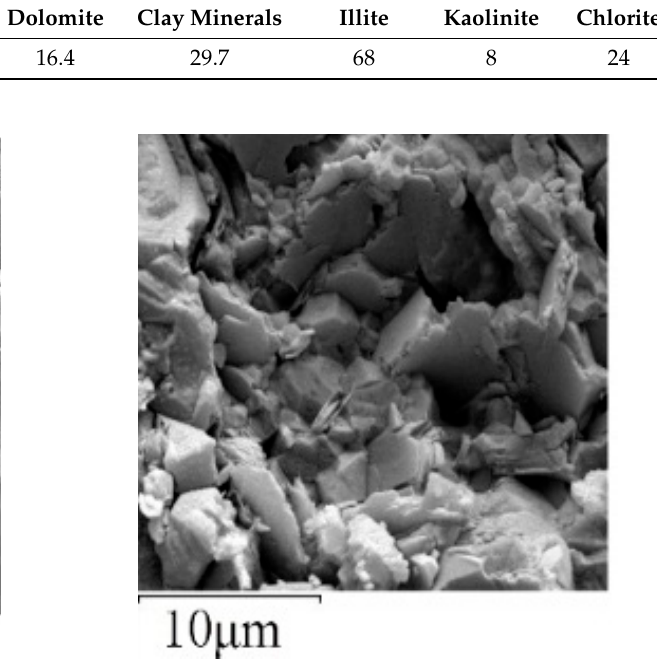
Figure 4. SEM experimental results of sandstone